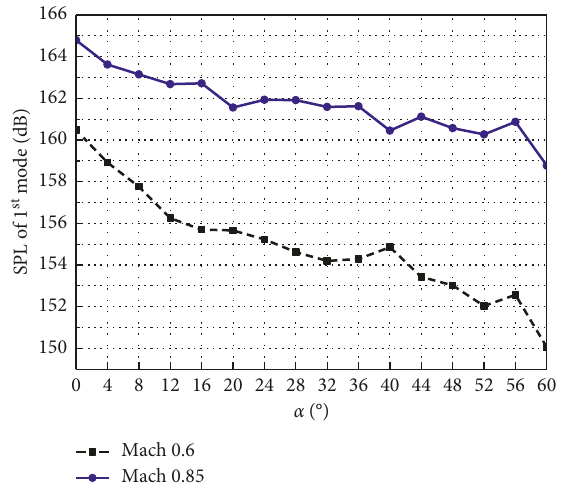
Figure 10: Comparison of the first mode SPLs of tonal noise at K 29.